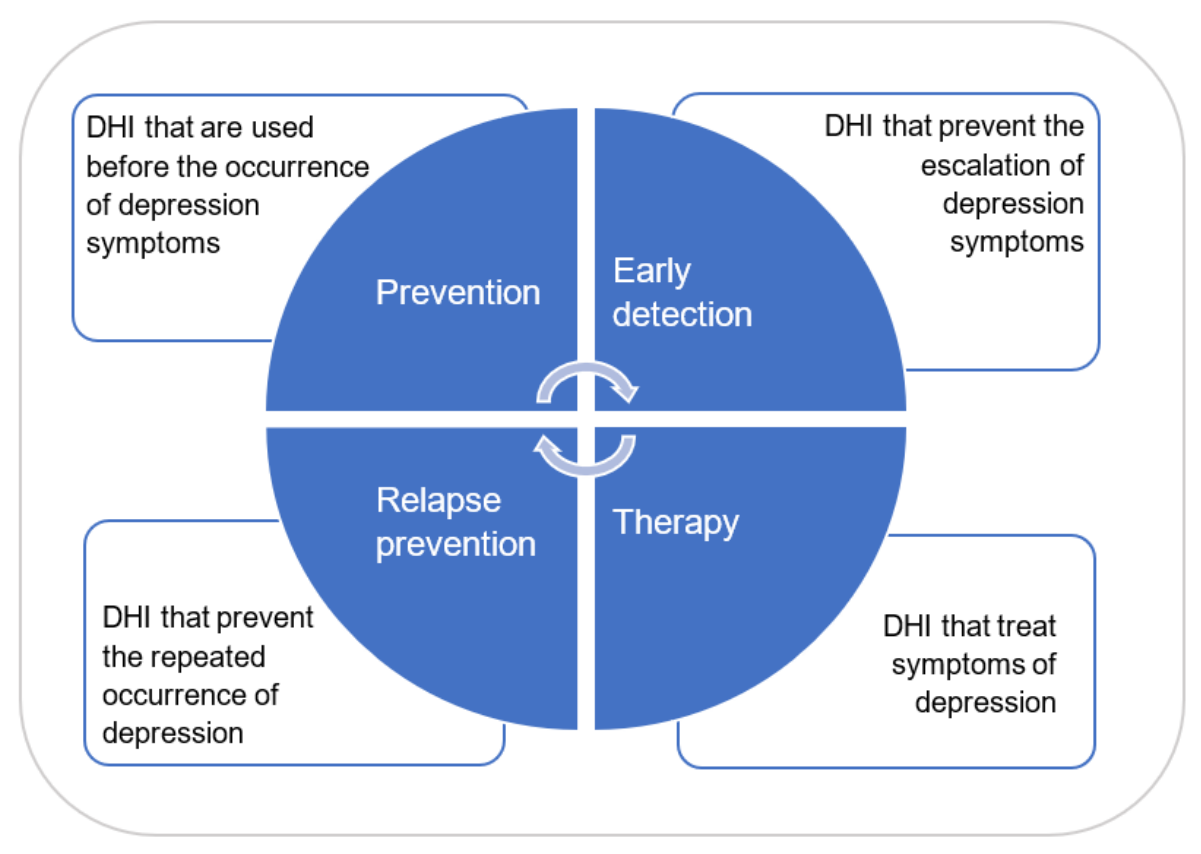
Figure 2. Classification of digital health intervention application